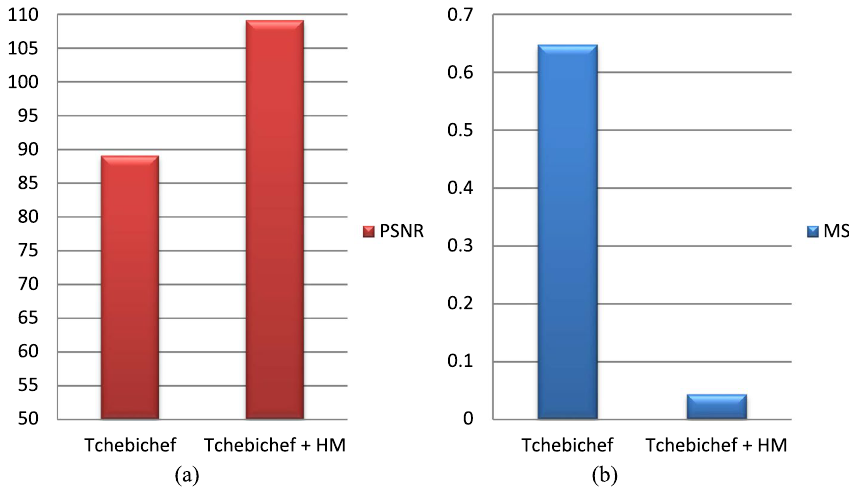
Fig. 1 The average values a PSNR and b MSE of the reconstructed signals using Tchebichef moments with and without Householder